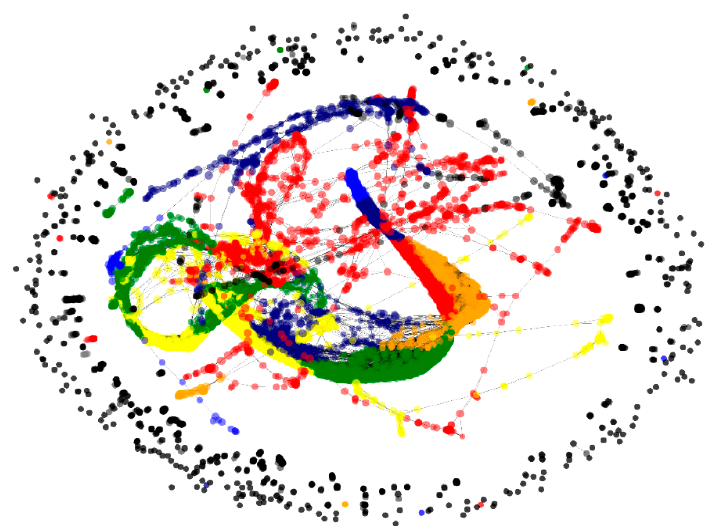
Figure 5. Reconstructed network where several communities of genes from different metabolic pathways are formed. These were visualised with Py3plex and are shown in different colours.